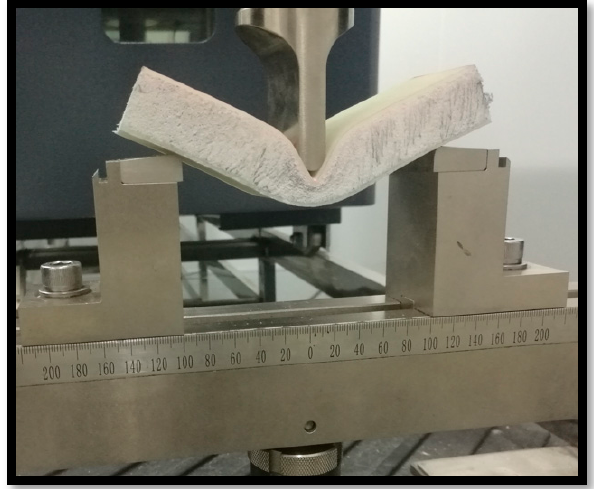
Figure 5. Sandwich composite specimen during three-point bending test.